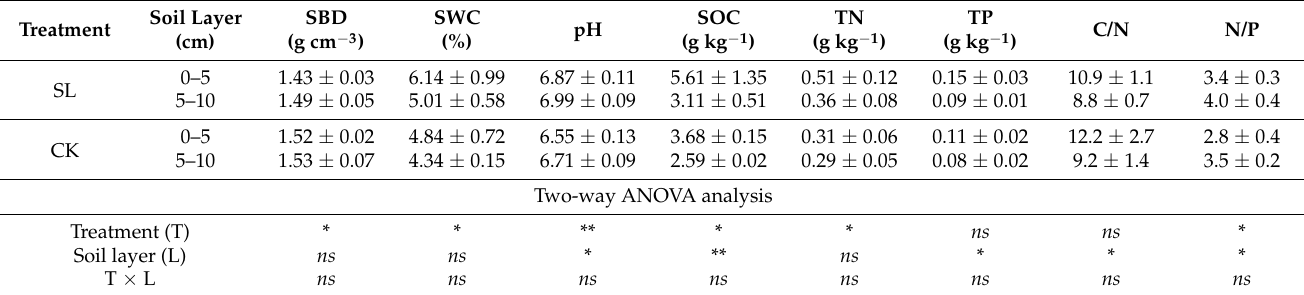
Table 3. Effects of sewage sludge (SS) application on soil bulk density (SBD), soil water content (SWC), pH, SOC, TN, TP, C/N, and N/P at the 0–5 and 5–10 cm soil layers in the Mongolian pine